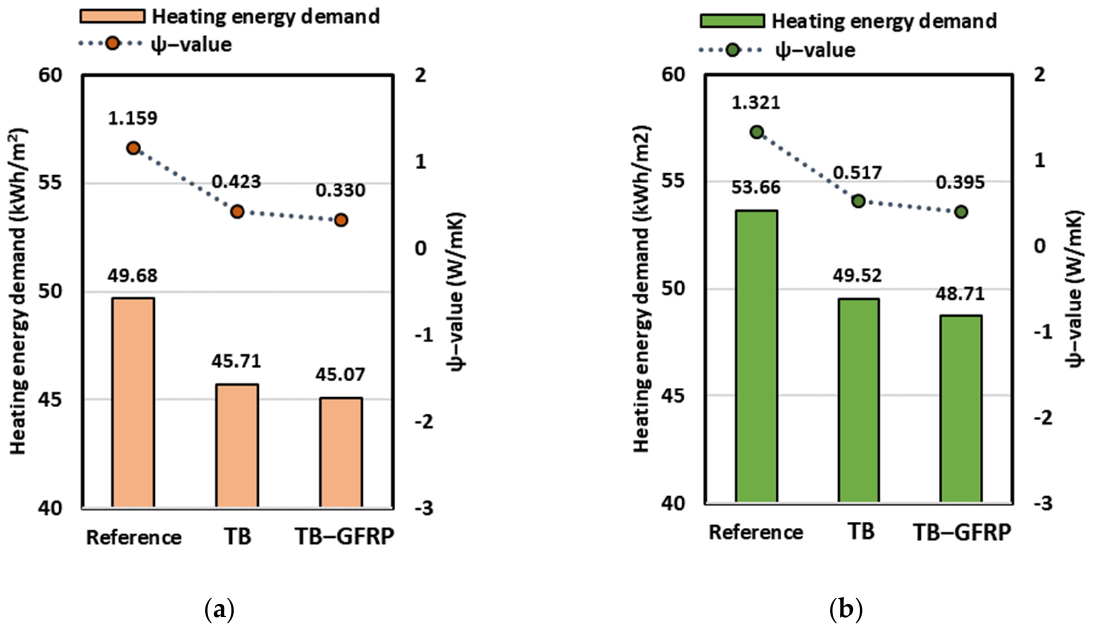
Figure 9. Heating energy demand under radiant floor heating condition: ( a ) External insulation; ( b ) Internal insulation.